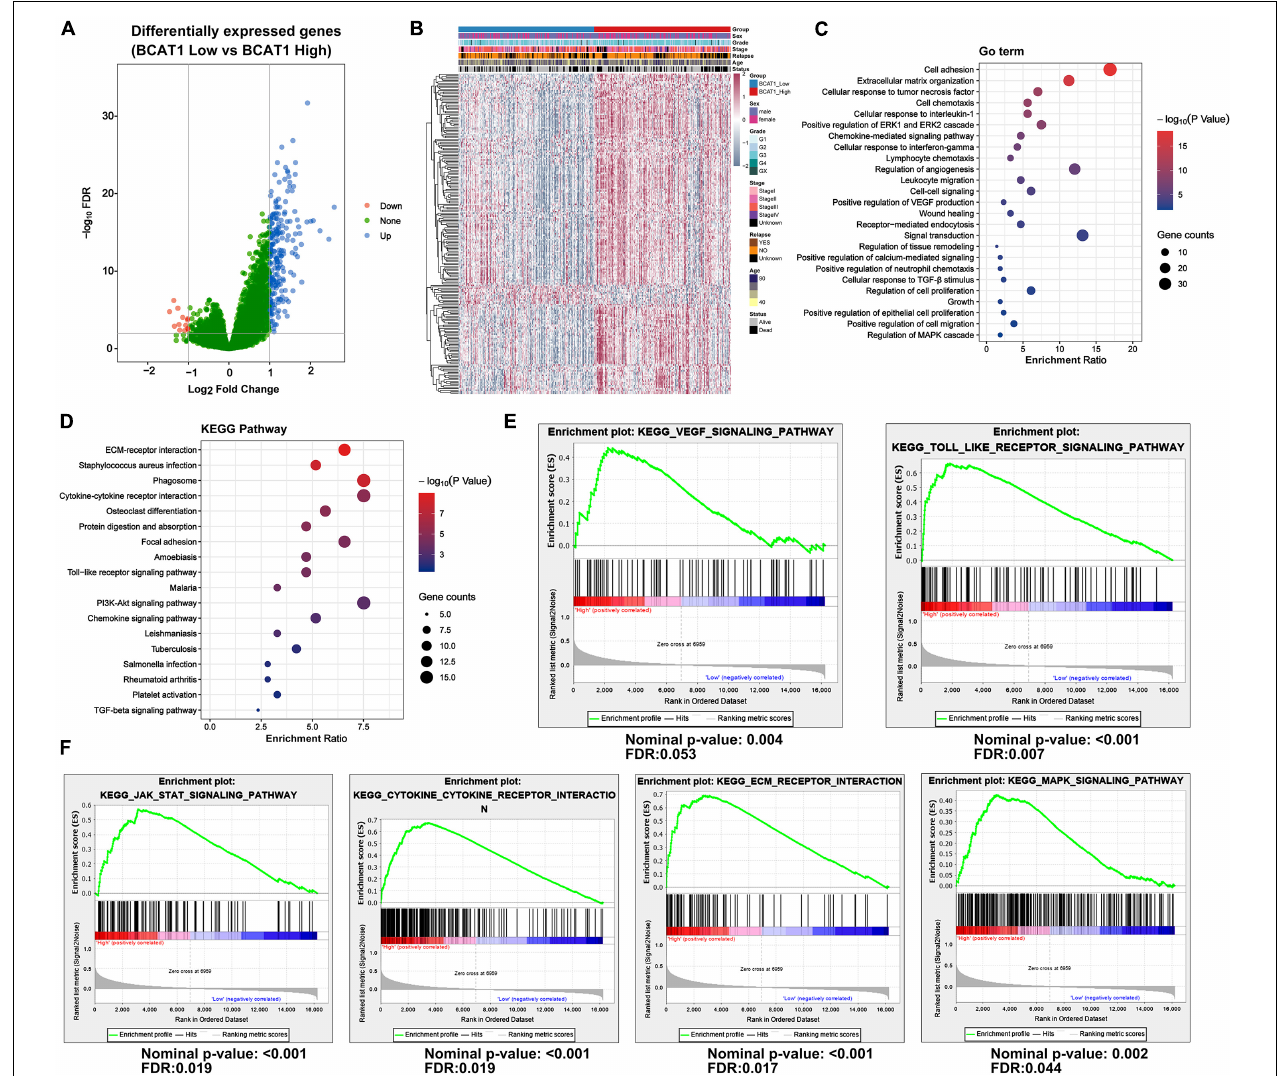
FIGURE 2 | BCAT1 regulates various downstream pathways in TCGA GC data. (A) Volcano plot and (B) heatmap showing DEGs between BCAT1-high and BCAT1-low expression groups in the TCGA GC dataset. (C) GO analysis and (D) KEGG pathway analysis revealed the representative enrichment pathways. (E) GSEA plot showing the positive correlation between BCAT1 and angiogenesis-related pathways. (F) GSEA plot showing the positive correlation between BCAT1 and invasion- or proliferation-related